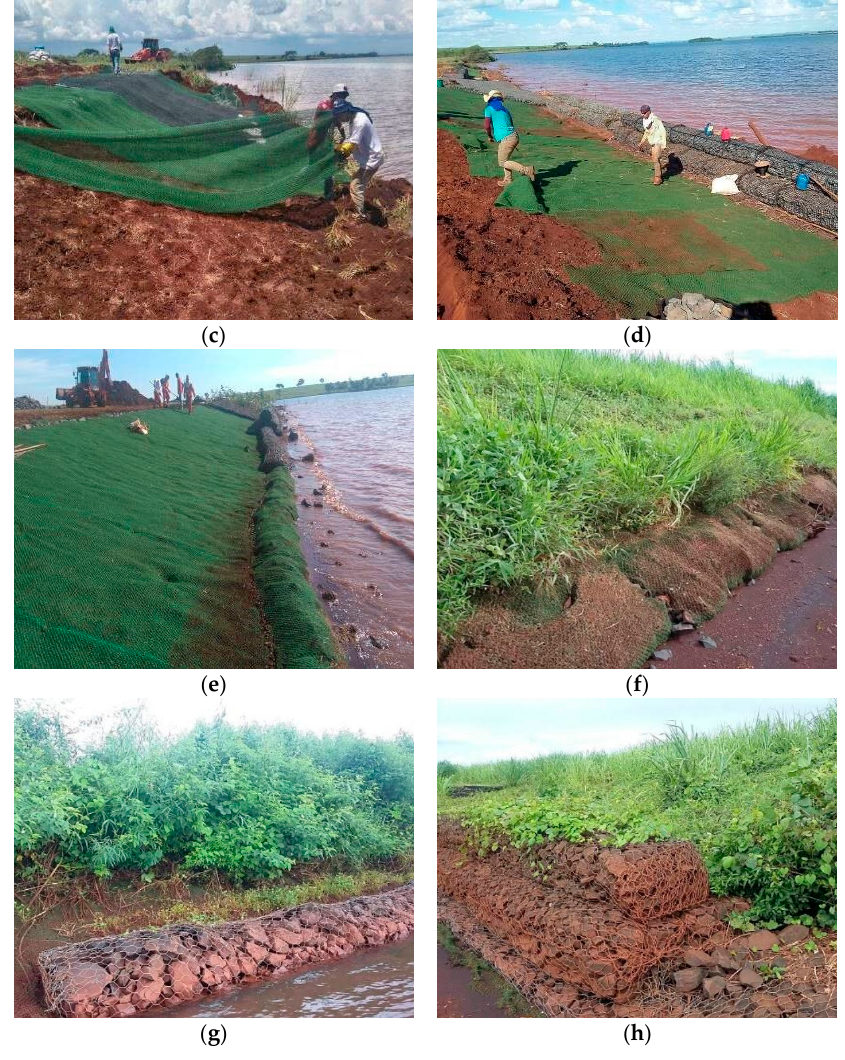
Figure A1. General installation procedures of the techniques: ( a ) mechanical reshaping of the margins, ( b ) construction of the anchor trench, ( c ) margin anchorage of the geomat, ( d ) sack gabion installation under the geomat, ( e ) final installation of the geomat erosion control technique, ( f ) geomat erosion control technique after two years of installation, ( g ) geomat and sack gabion after two years of installation, and ( h ) geomat and sack gabion after four years of installation.